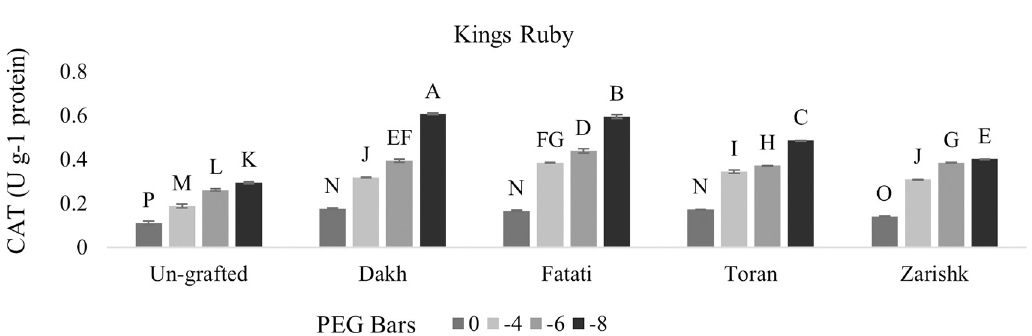
Fig 11. Catalase (CAT) enzymatic activity of un-grafted and grafted Kings Ruby scion variety grafted on different wild grapevines under drought stress condition. Data is represented as mean SD and letters showed significant difference at p <